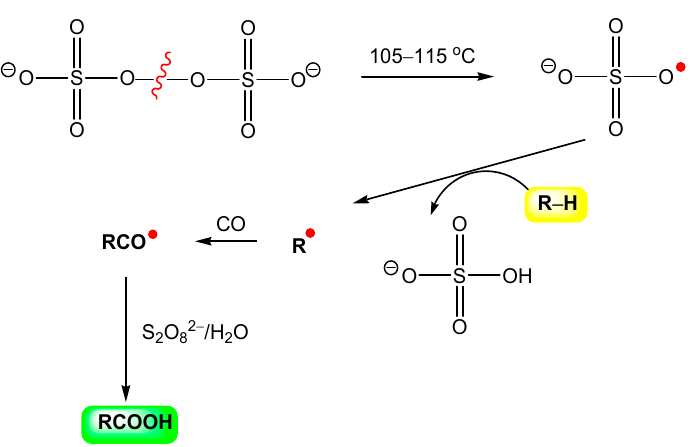
Figure 23. Hydrocarbonylation of alkane, RH, with hexaoxo ‐ μ ‐ peroxodisulfat , S 2 O 82 ‒ , and CO. Adapted from Ref. [308].